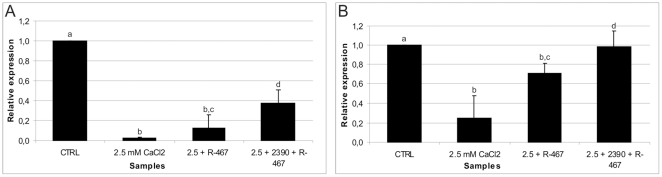
CaSR transcript relative abundance in eUCM-MSCs upon
Ca2+- or calcimimetic-induced CaSR
stimulation.Quantitative Real Time RT-PCR analysis of the CaSR transcript in
Ca2+ (2.5 mM CaCl2) and
calcimimetic-treated (2.5+R-467) equine UCM-MSCs versus controls
(CTRL) or cells pre-incubated with the CaSR antagonist
(2.5+2390+R-467). Cells were examined on day 4th
after treatments. For each sample, data (mean ± SD of three
independent experiments in duplicate, CaSR average Ct) were normalized
relatively to the abundance of HPRT1 mRNA (endogenous control) and
normalized values were compared among groups. In the large cell line
(panel A), CaSR transcription was strongly down-regulated in presence of
additional Ca2+ (2% of control value; vs b:
P<0.001) and NPS R-467 (13%; a vs b: P<0.001). In the small
cell line (panel B), CaSR transcription was again down-regulated by
additional Ca2+ (25%; a vs b: P<0.001) and NPS
R-467 (72%; a vs b: P<0.001) even at a lesser extent. In both
cell lines, the CaSR antagonist NPS 2390 reversed the effects of NPS
R-467 (38% and 97%, for the large and the small cell line,
respectively; c vs d: P<0.05).